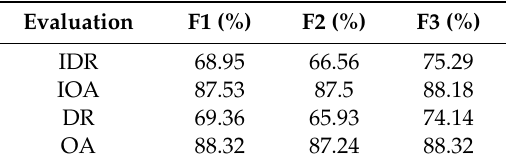
Figure 9. Extraction of GF3 with three feature sets. ( a ) F1 +ANSNPE+SVM ( b ) F2+ANSNPE+SVM ( c ) F3+ANSNPE+SVM. Yellow shows the incorrect building areas, which are extracted; green shows the properly extracted building areas; red shows the building areas not being extracted; and gray shows the non-built areas. Table 7. Extraction Accuracy of GF3 data.